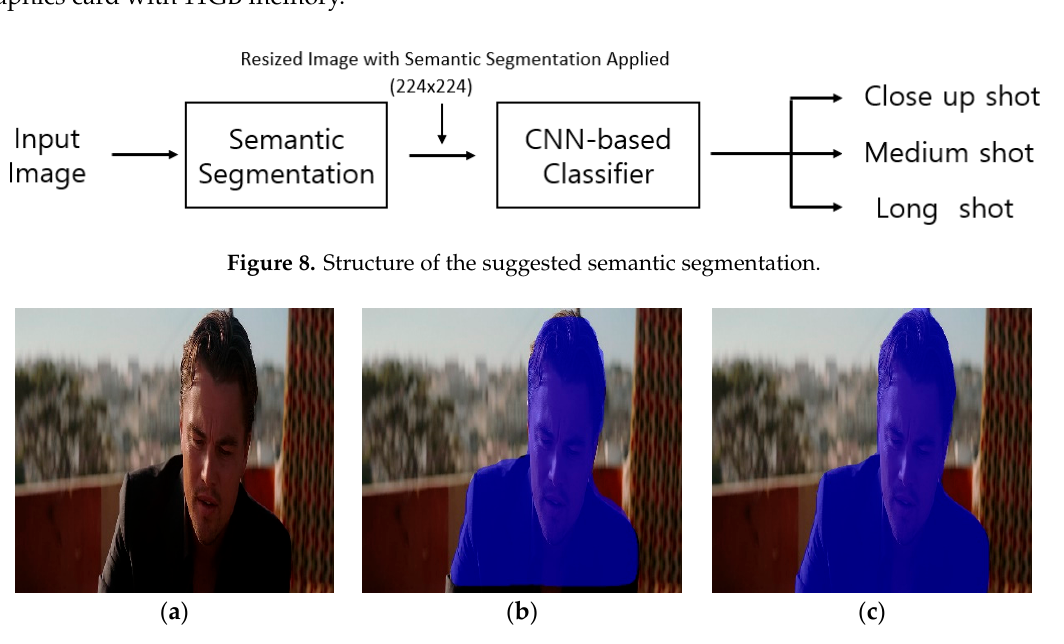
Table 1. Number of Frames.